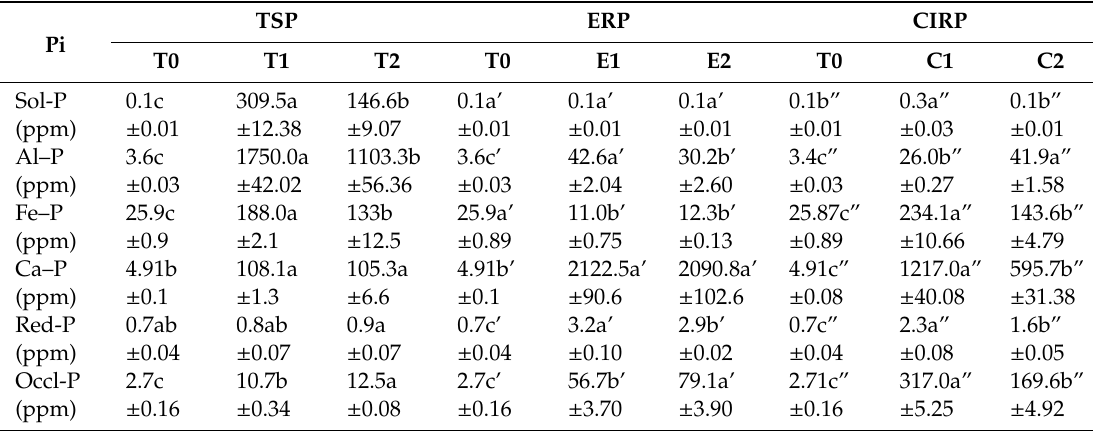
Table 6. Inorganic phosphorus speciation of soil at ninety days after